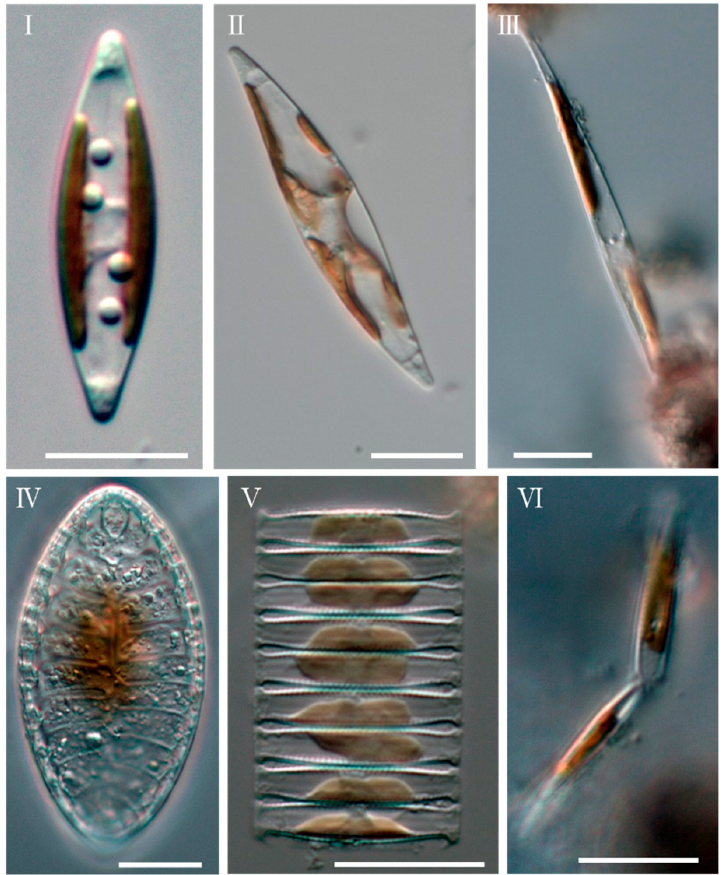
Figure 6. Photomicrographs of representative pennate diatoms by direct microscopic observation; ( Ⅰ ) Naviculoid type diatom, ( Ⅱ ) Haslea sp., ( Ⅲ ) Nitzschia sp., ( Ⅳ ) Surirella sp., ( Ⅴ ) Fragilariopsis sp., ( Ⅵ ) unidentified pennate diatoms. Scale bars are 20 µm.